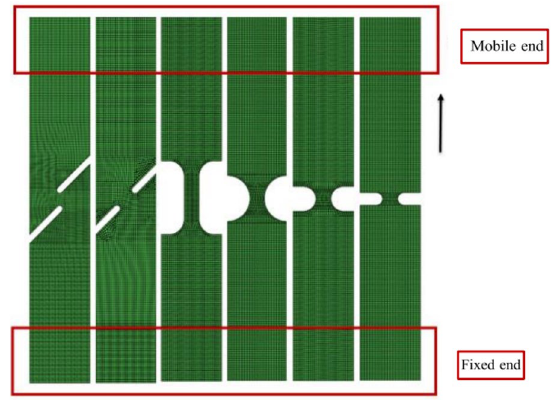
Figure 5 Finite element models of specimens